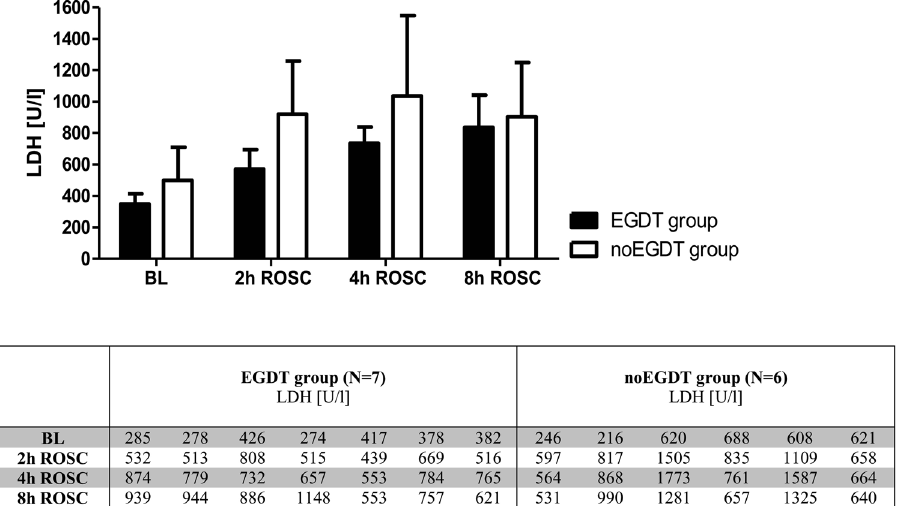
Figure 5. Mean catalytic activities of plasma LDH at baseline, 2 h, 4 h and 8 h after ROSC in the EGDT and noEGDT group (upper panel). Colunms show the mean, bars denote SD. Catalytic LDH activities for each animal are depicted in the table (lower